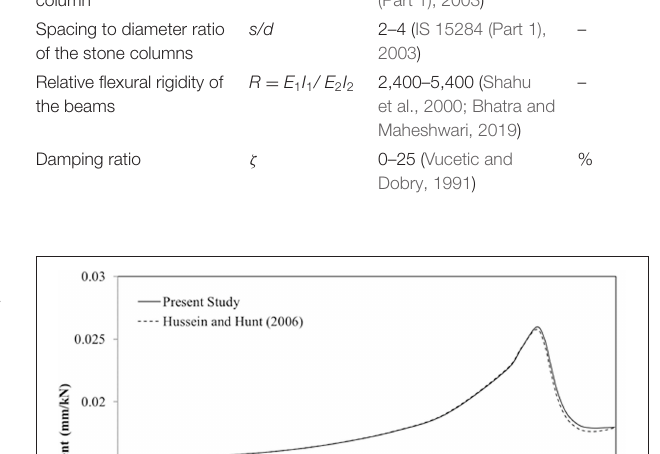
Figure 4 . It has been observed that maximum